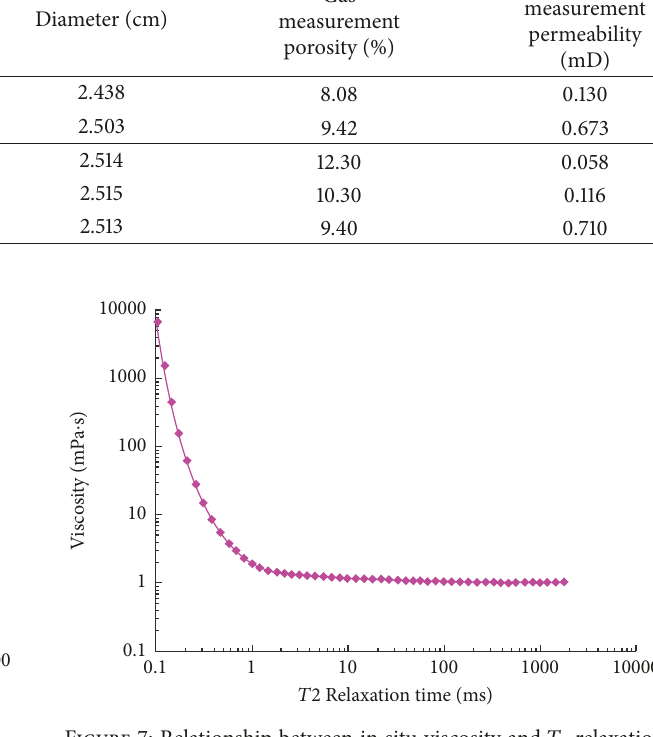
Figure 7: Relationship between in situ viscosity and 𝑇 2 relaxation time of 0.130 mD rock core after saturated water.